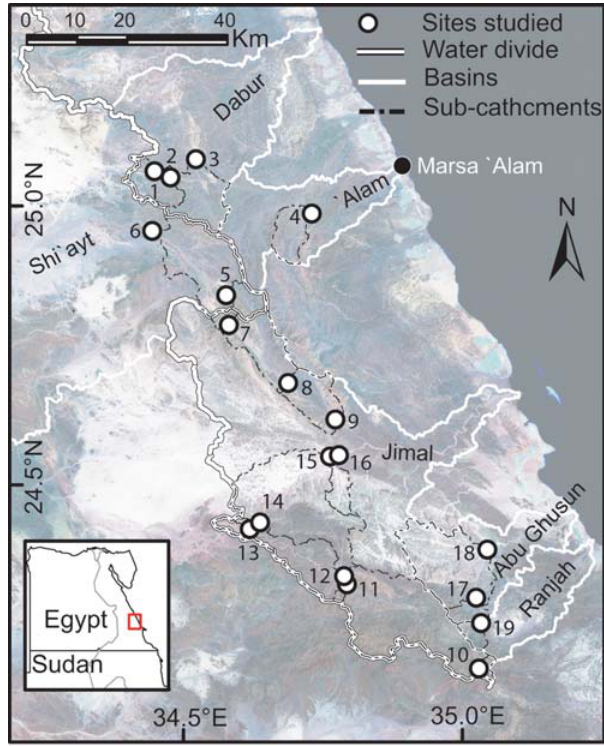
Figure 1. Study area. Studied sites in relation to basins, sub-catchments and east-west water divide. Each site is labelled with its ID (see Table 1). A Landsat TM image is displayed in the background.